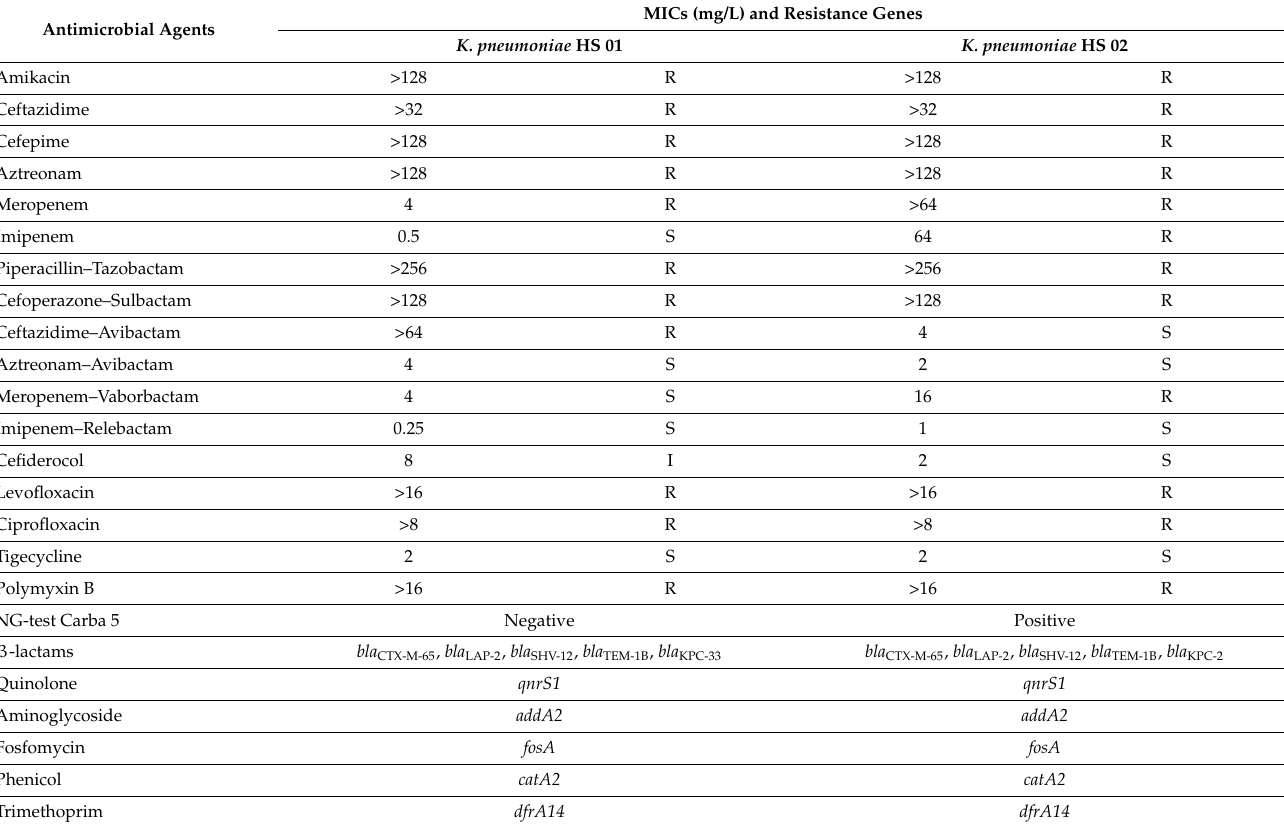
Table 1. Antimicrobial susceptibility and resistance genes of K. pneumoniae HS01 and K. pneumoniae HS02. MICs (mg/L) and Resistance Antimicrobial Agents